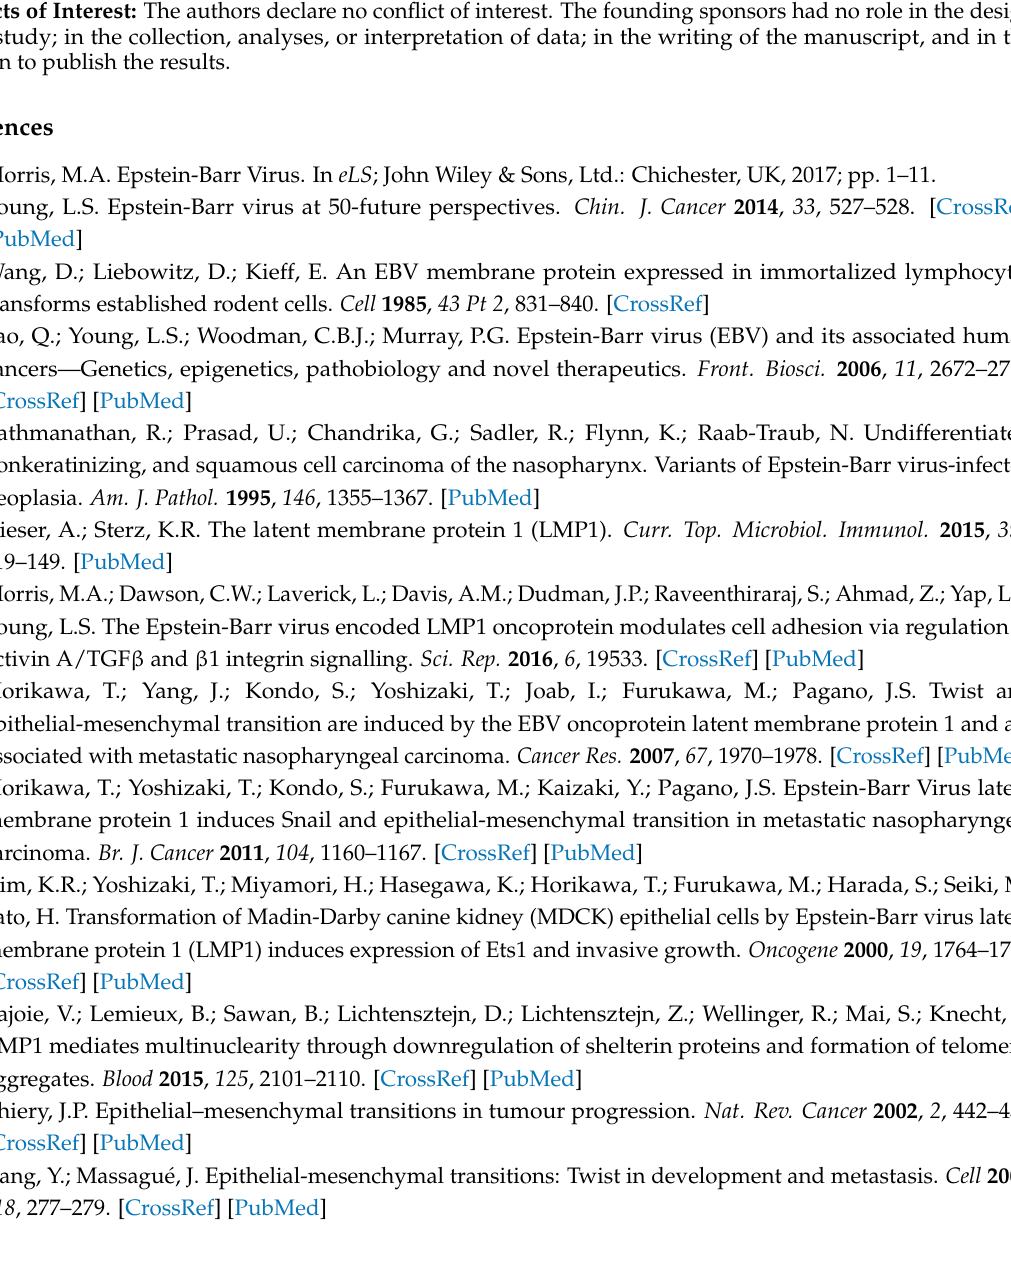
mutants on the expression of genes encoding adherens junction and focal adhesion proteins; Figure S3: Intracellular expression and distribution of cell adhesion proteins in MDCKs expressing wildtype and CTAR-inactivating LMP1 mutants; Figure S4: Validation of EMT markers in MDCKs expressing wildtype and CTAR-inactivating LMP1 mutants; Figure S5: Characterisation of integrin expression in MDCKs expressing wildtype and CTAR-inactivating LMP1 mutants; Table S1: Genes (with Entrez ID) upregulated in array compared with control cells; Table S2: Genes (with Entrez ID) downregulated in array compared with control cells; Table S3: Adherens junction and focal adhesion signalling genes differentially regulated by LMP1; Table S4: List of pharmacological inhibitors used; Table S5: Complete list of plasmids used; Table S6: Complete list of antibodies used in immunofluorescence; Table S7: Complete list of antibodies used in Western blotting; Table S8: Complete list of 5 (cid:48) and 3 (cid:48) primer combinations